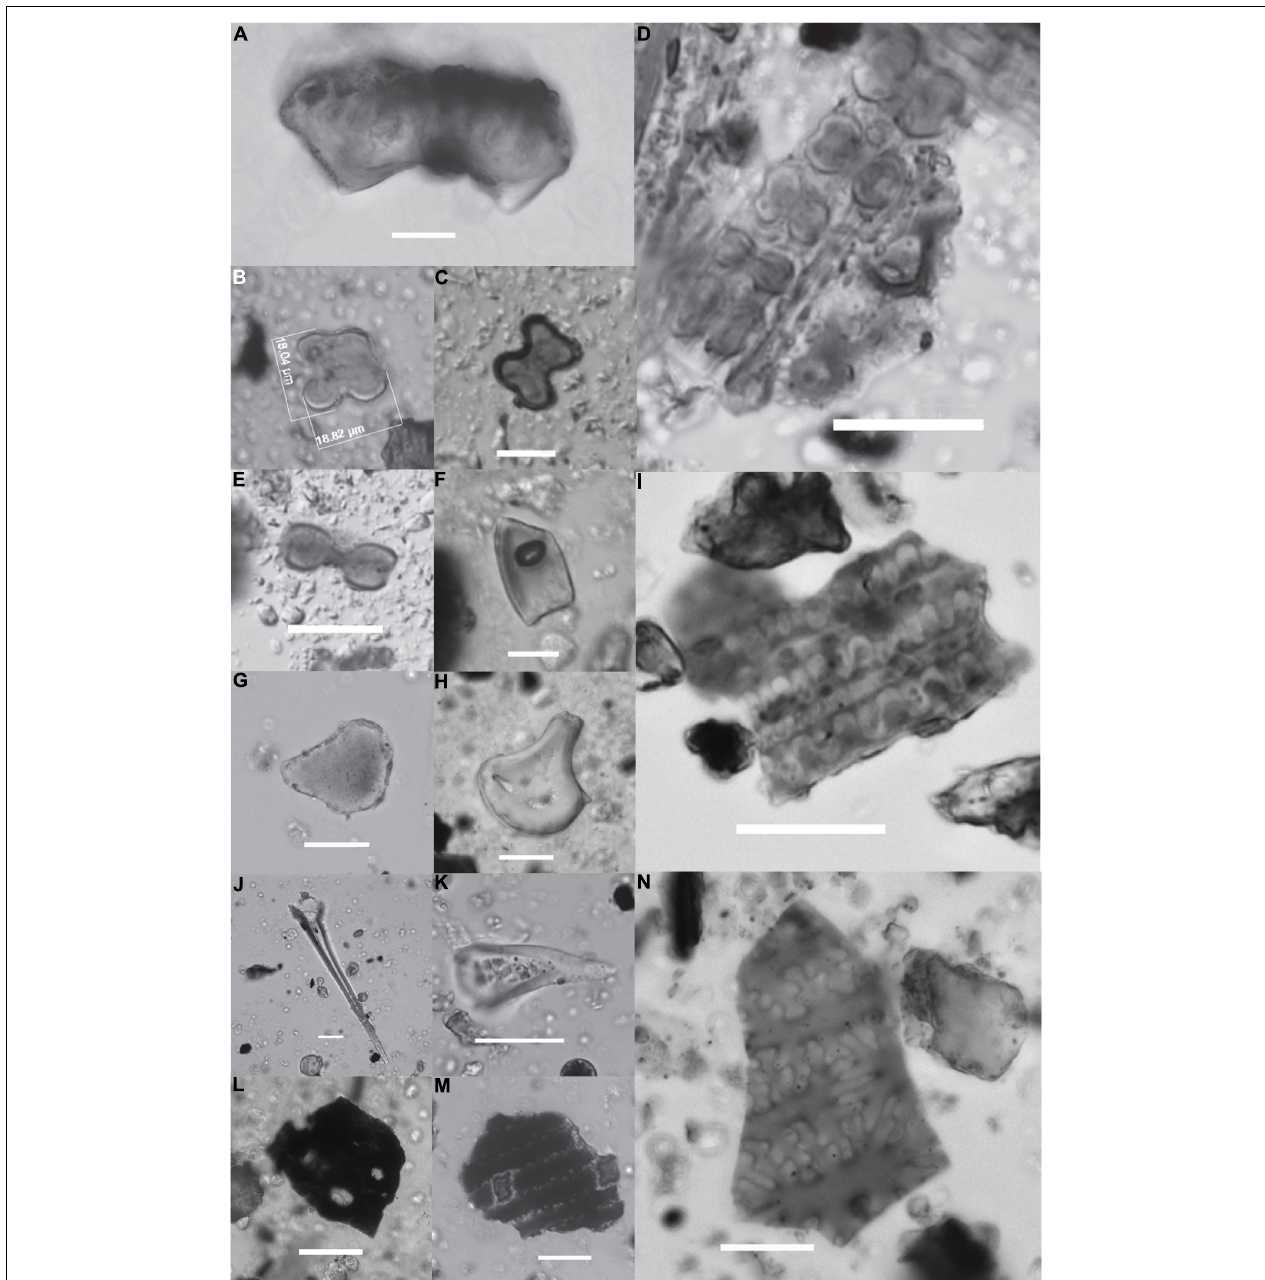
FIGURE 5 | Phytolith remains from Erlitou pottery vessels. (A) Rice double-peak husk; (B) Job’s tears cross; (C) cross; (D) Oryzoideae scooped parallel bilobate; (E) bilobate; (F) rondel; (G) common bulliform; (H) rice bulliform; (I) dendriform husk, possibly Triticeae; (J,K) hair cell; (L) opaque perforated platelets; (M) burnt Elongate sinuate skeleton; (N) broomcorn millet η -type husk. (Scales, C,F : 10 µ m; L: 50 µ m; rest: 20 µ